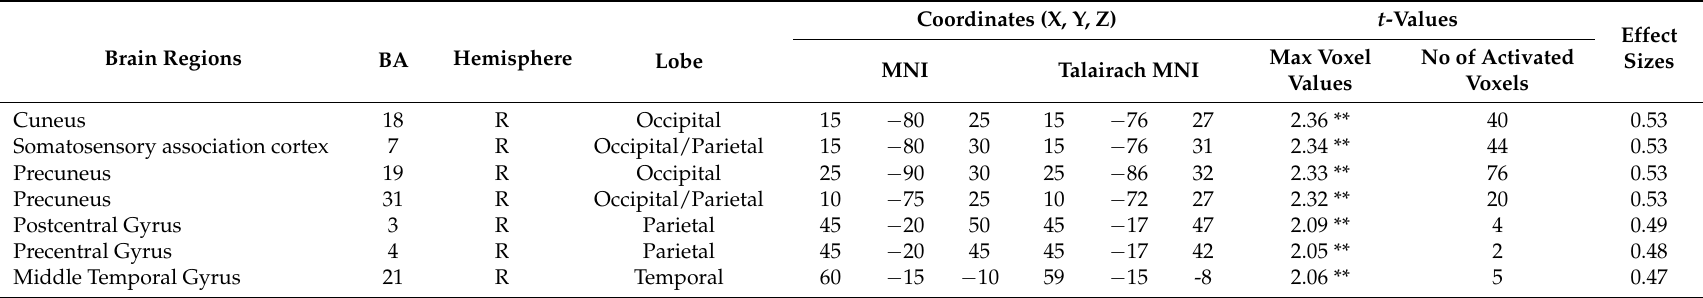
Table 4. Standardized low-resolution brain electromagnetic tomography (sLORETA) results of maximal brain electrical activity for the oddball effect (rare vs. frequent: 348 ms latency) for the control